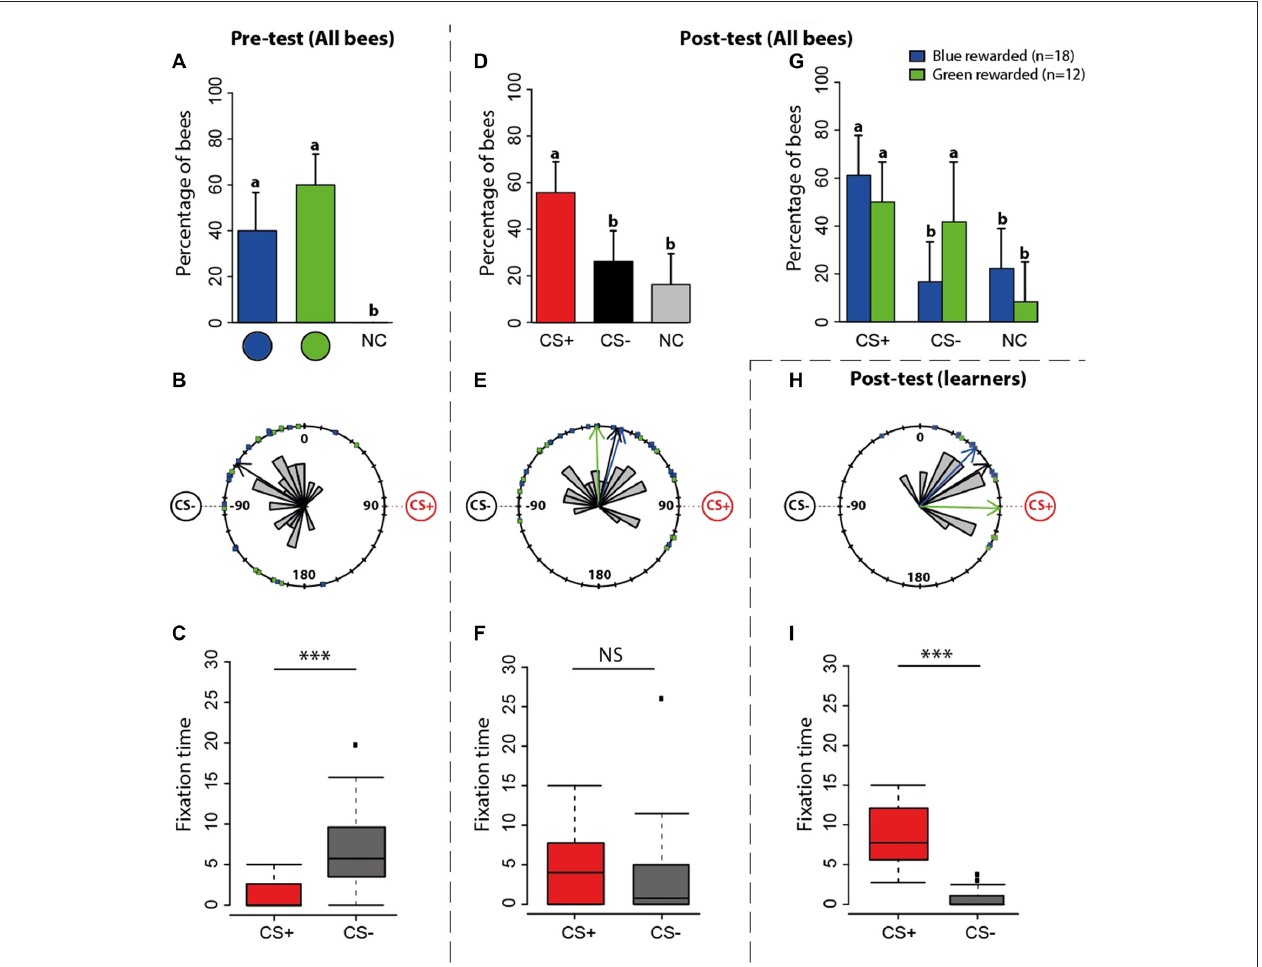
FIGURE 3 | Experiment 1: spontaneous preferences (pre-test) and learning-induced preferences (post-test) at the VR setup. (A) Percentage of bees ( n = 30) choosing first either the green disc, the blue disc or not making a choice (NC) during the pre-test. The 95% confidence interval is shown in each case. (B) Circular distribution of orientation vectors of bees during the pre-test. Note that while the stimuli appeared at 45 ◦ to the left and right of the main axis of the bee body, they appear at 90 ◦ to the left and right in these circular plots because 2 ◦ of ball rotation corresponded to 1 ◦ of stimulus rotation. Thus, a vector pointing towards 90 ◦ represents a bee oriented towards a visual stimulus located at 45 ◦ to the right of the central axis of the bee body. The black arrow inside the distribution is the mean resultant vector of the group of bees ( n = 30, n < 0.0001). The blue arrow shows the mean resultant vector of bees preferring the blue disc ( n = 12, p < 0.0001); the green arrow shows the same for bees preferring the green disc ( n = 18, p < 0.0001; here blue and green arrows fully coincide with the black arrow and cannot be seen). Although at this stage of the experiment there is neither a CS+ nor a CS − , we use these terms to indicate the stimuli that will become CS+ and CS − during the subsequent training. (C) Fixation time (in seconds; median, quartiles and outliers) of the CS+ (red boxplot) and of the CS − (gray boxplot) during the pre-test. The terms CS+ and CS − are used here in the sense indicated above. (D) Percentage of bees ( n = 30) choosing first either the CS+, the CS − disc or not making a choice (NC) during the post-test. The 95% confidence interval is shown in each case. (E) Circular distribution of orientation vectors of bees during the post-test. The black arrow inside the distribution is the mean resultant vector of the entire group of bees ( n = 30, p = 0.18). The blue arrow shows the mean resultant vector of bees rewarded on the blue disc ( n = 18, p = 0.11); the green arrow shows the same for bees rewarded on the green disc ( n = 12, p = 0.51). (F) Fixation time (in seconds; median, quartiles and outliers) of the CS+ (red boxplot) and of the CS − (gray boxplot) during the post-test. (G) Percentage of bees choosing first either the CS+, the CS − disc or not making a choice (NC) according to the color onto which they were rewarded. The 95% confidence interval is shown in each case. (H) Circular distribution of orientation vectors of learners (i.e., bees that chose first the CS+ in the post-test) during the post-test. The black arrow inside the distribution is the mean resultant vector of the entire groups of learners ( p = 17, < 0.0001). The blue arrow shows the mean resultant vector of learners rewarded on the blue disc ( p = 11, n = 0.003); the green arrow shows the same for learners rewarded on the green disc ( n = 6, p = 0.002). (I) Fixation time (in seconds; median, quartiles and outliers) of the CS+ (red boxplot) and of the CS − (gray boxplot) by learners during the post-test. (A,D,G) Different lower-case letters above bars indicate significant differences ( p < 0.05). The position of the stimuli was varied between bees during the pre-test; data were normalized to display always the CS+ on the left side and the CS − on the right side. (C,F,I) Bees were considered as fixating a stimulus when they were at 90 ◦ ± 20 ◦ for the CS+ and − 90 ◦ ± 20 ◦ for the CS − . ∗ p < 0.05; ∗∗ p < 0.001, ∗∗∗ p < 0.0001; NS, non-significant.